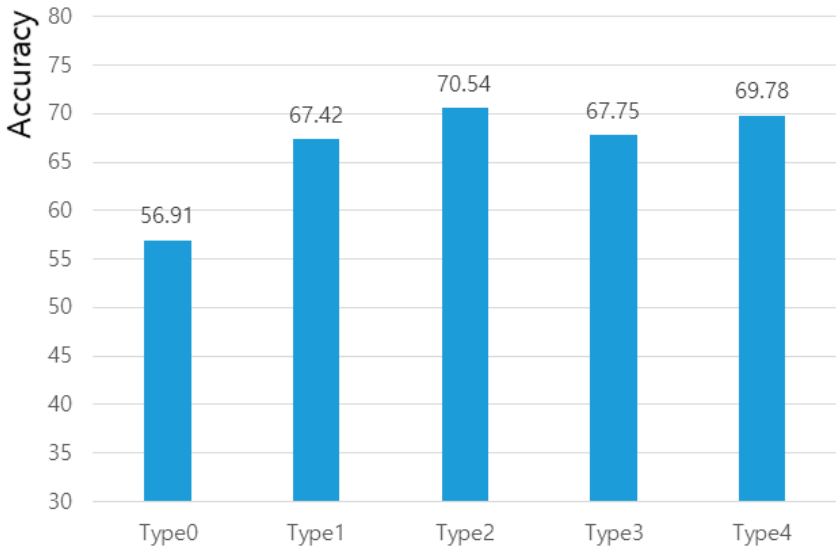
Figure 22. Comparison of the average total accuracies for the different types of preprocessing under transfer learning.